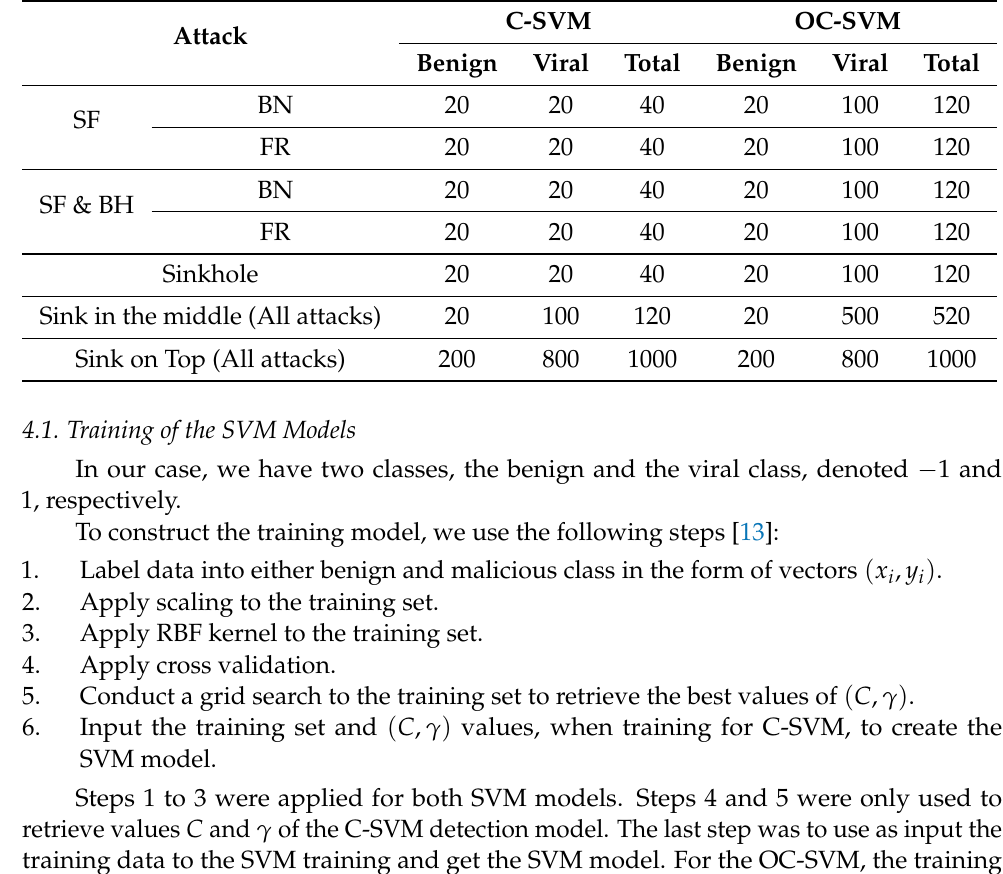
Table 3. SVM evaluation data set when Sink is in the middle.